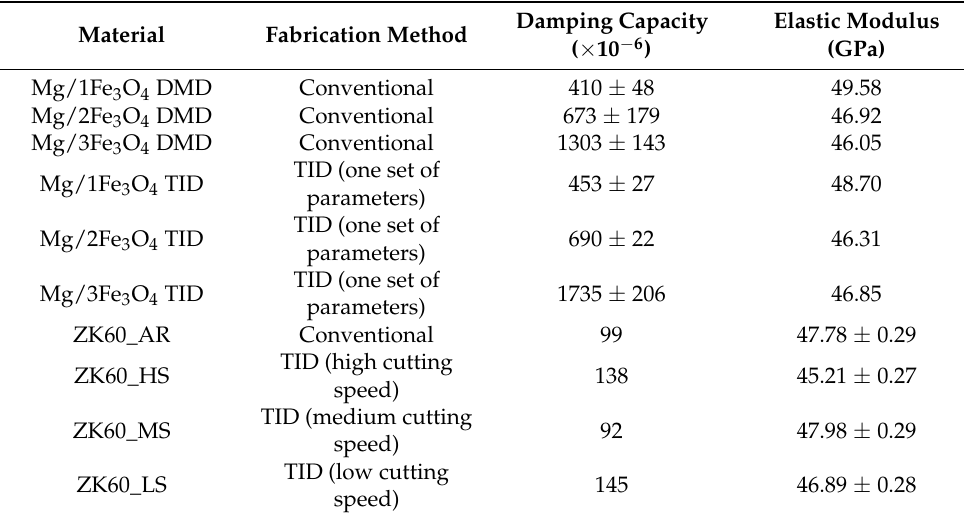
Table 3. Damping capacities and elastic modulus of Mg materials undergoing both conventional and TID method processing [24,25].